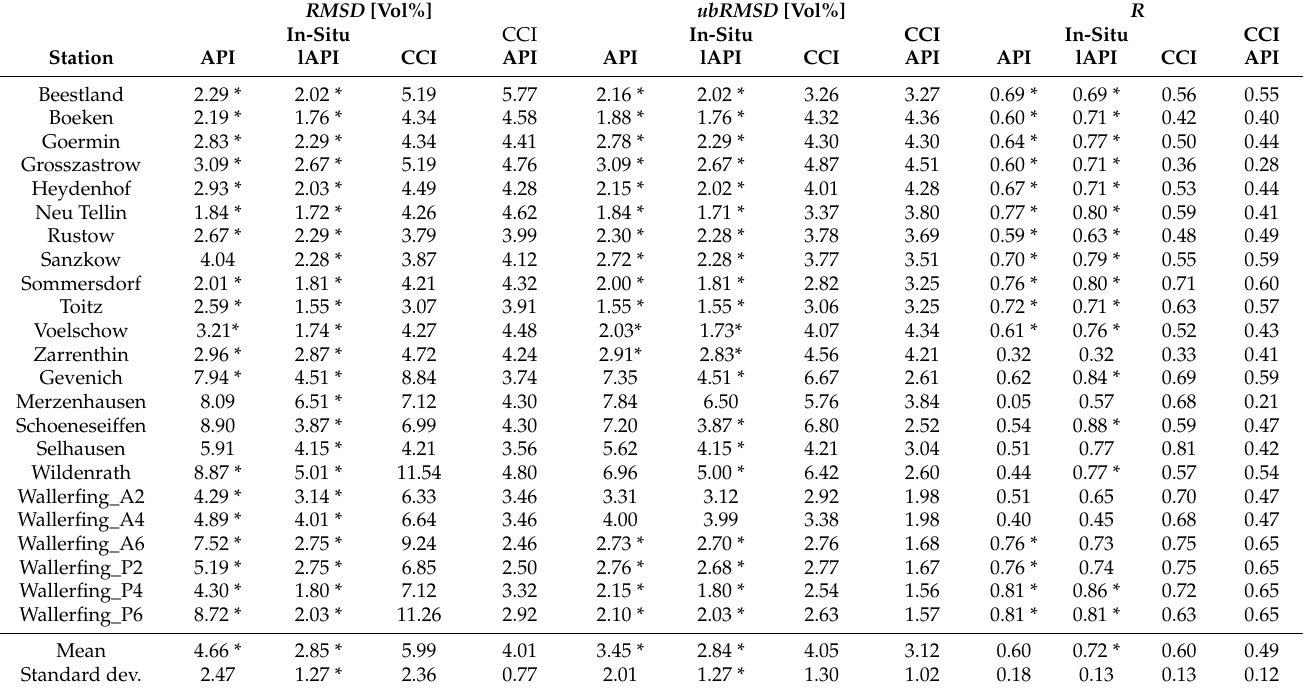
Table 2. Evaluation of the overall and locally optimized API and ESA CCI SM data against local measurements; and evaluation of ESA CCI SM against overall optimized API; masks are applied as described in the text; the asterisk (*) indicate lower ( ub ) RMSD and higher R values of the API respectively in comparison to ESA CCI SM data when benchmarked against the local